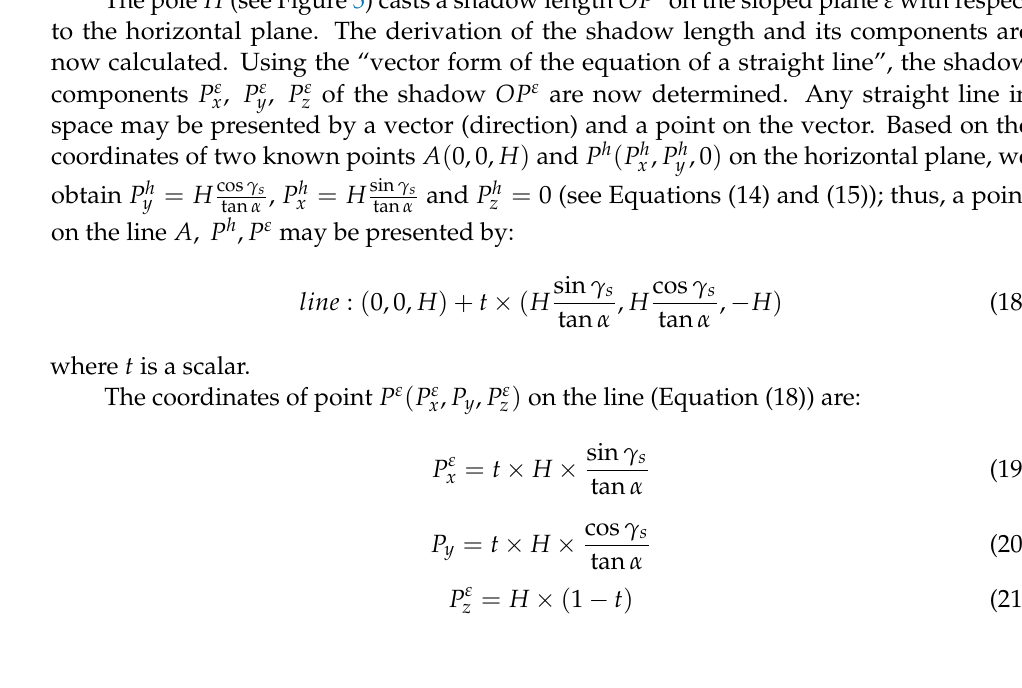
β on a horizontal plane at point ε .